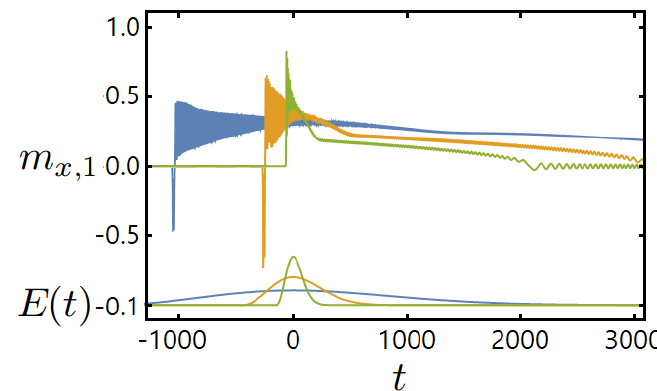
Figure 9: Time evolution of the order parameter, m , at r = 640 and different x ,1 values of τ and E such that F in Eq. (28) is kept constant at the value 15.53. In 0 = 0.105 (blue curve), τ = 1000 and E = 0.2 particular, we use τ = 5000 and E 0 0 = 0.35 (green curve). The curves have been shifted (orange curve), τ = 250 and E 0 so that t = 0 corresponds to the peak amplitude of the pulses, shown in the lower part of the